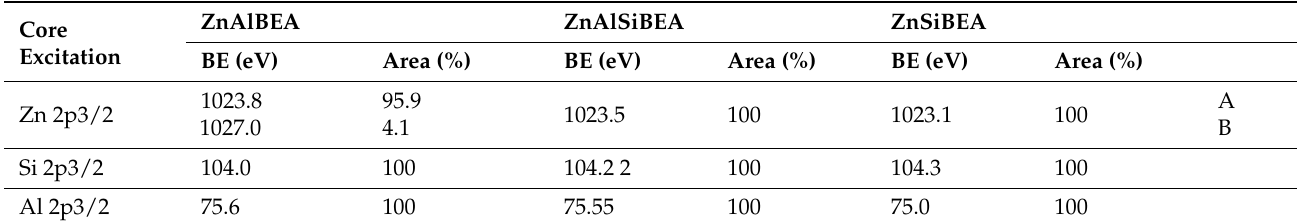
Table 3. XPS data of Zn-BEA